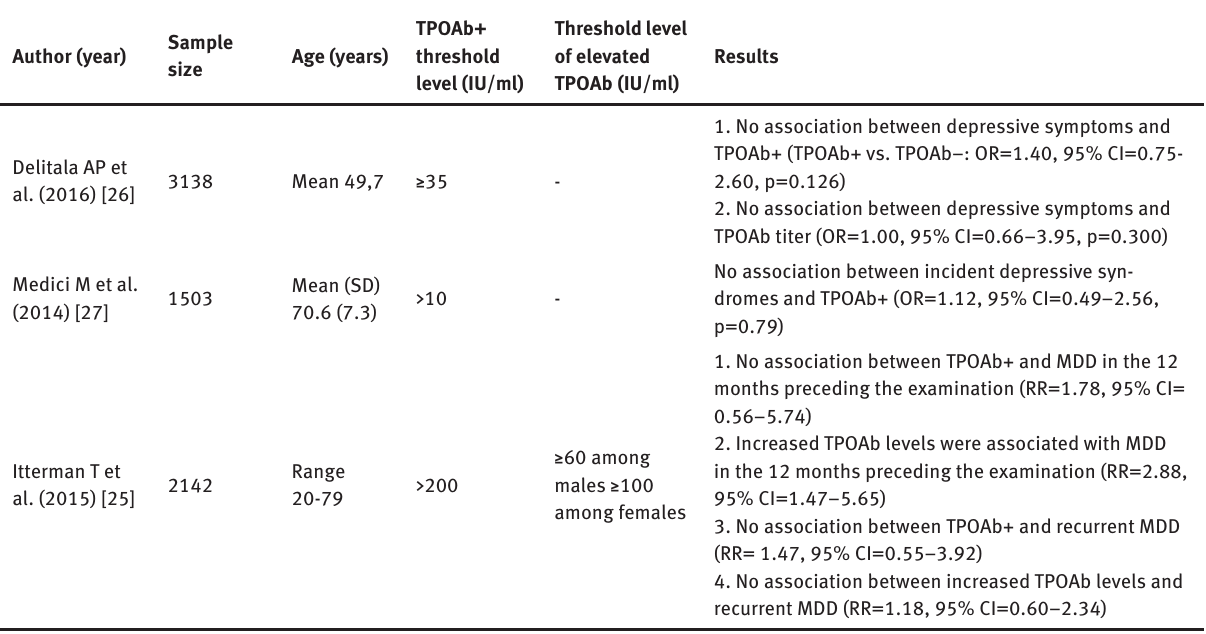
Table 2: Studies assessing the link between increased thyroid antibody levels and depressive symptoms among the general population